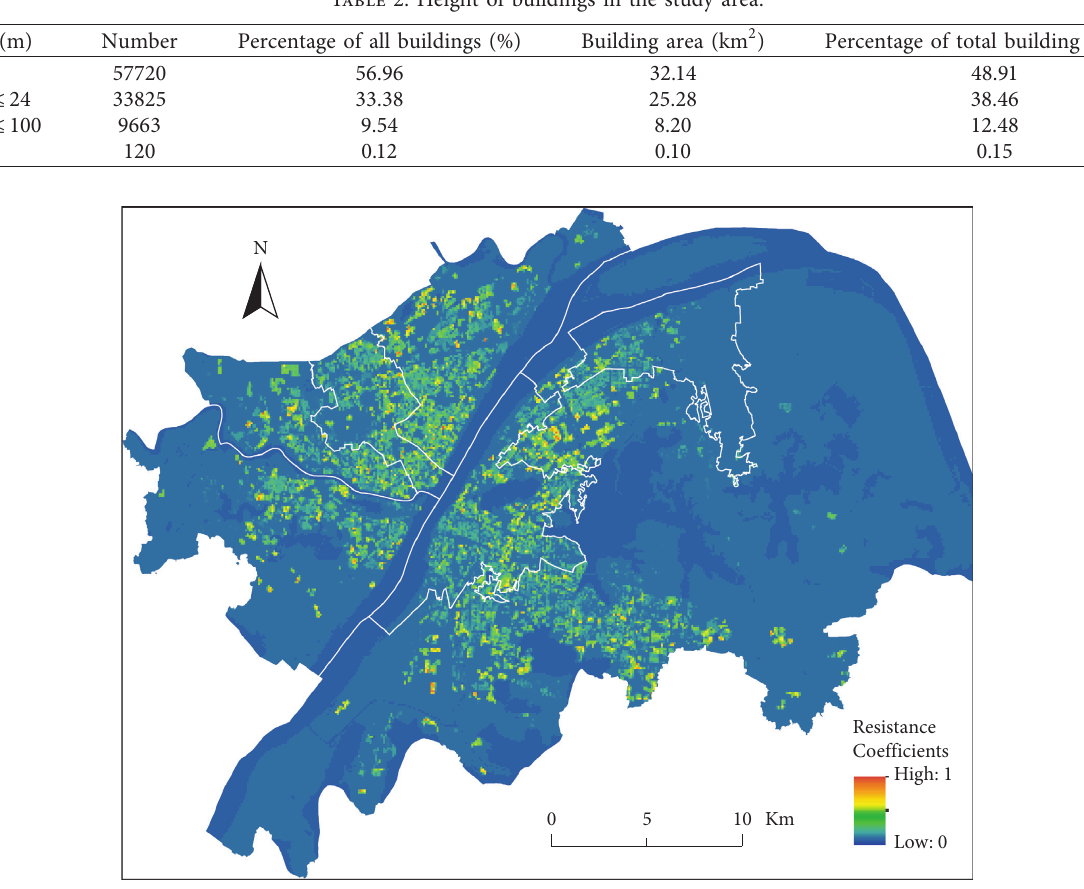
Figure 4: Resistance coefficients